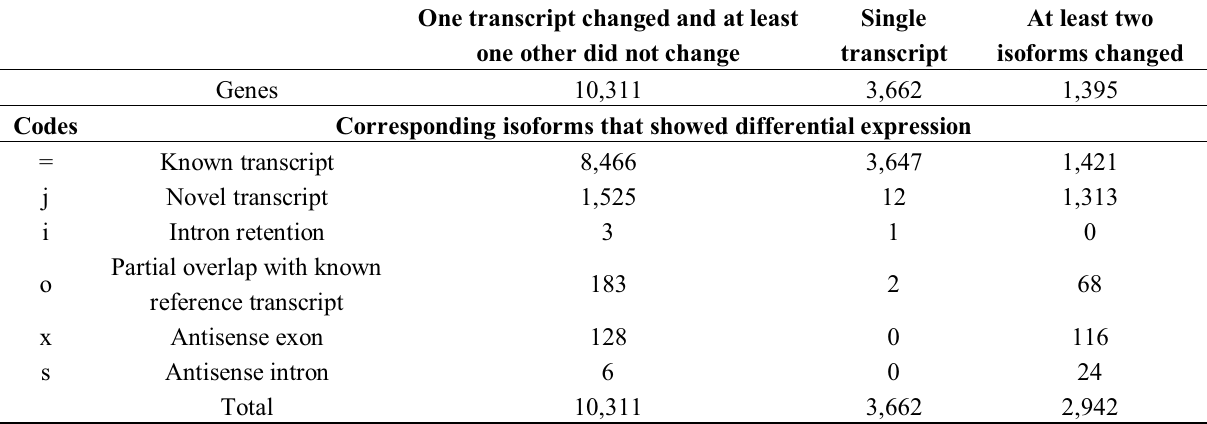
Table 2. Distribution of isoforms among Cuffcompare classes. The 16,915 transcripts